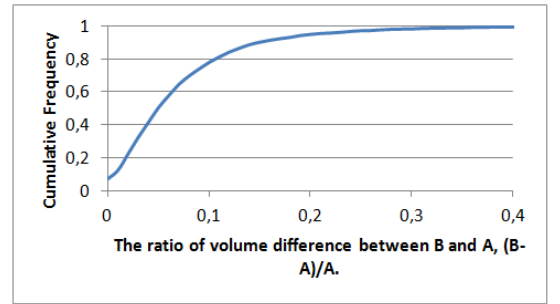
Figure 8. Cumulative Frequency of the Ratio of Volume Difference between C and A